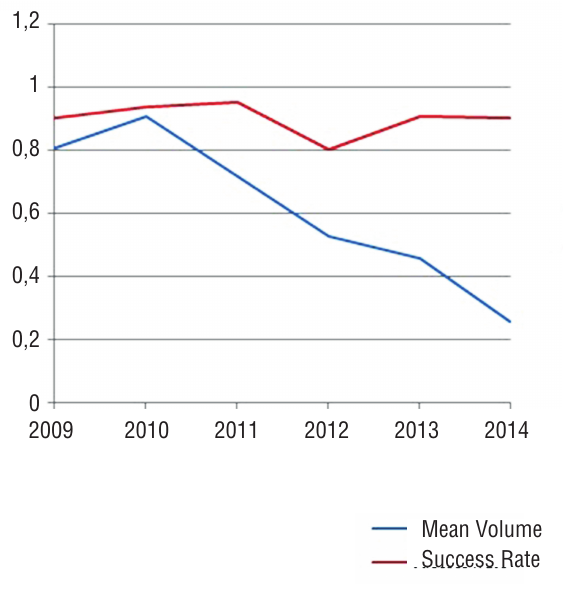
Figure 1 - The success rate did not change significantly through the